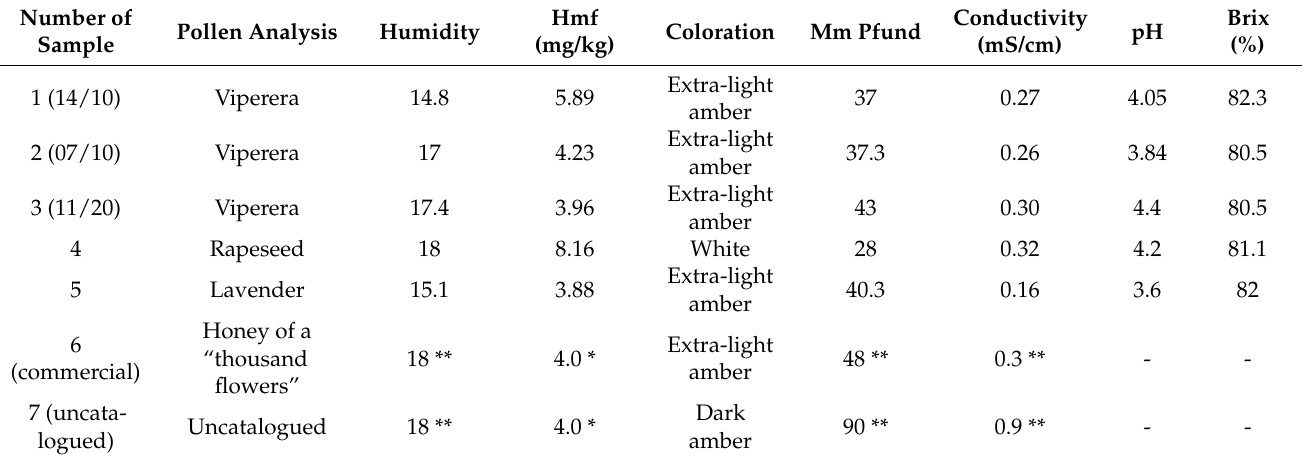
Table 1. Physicochemical analysis of the analyzed